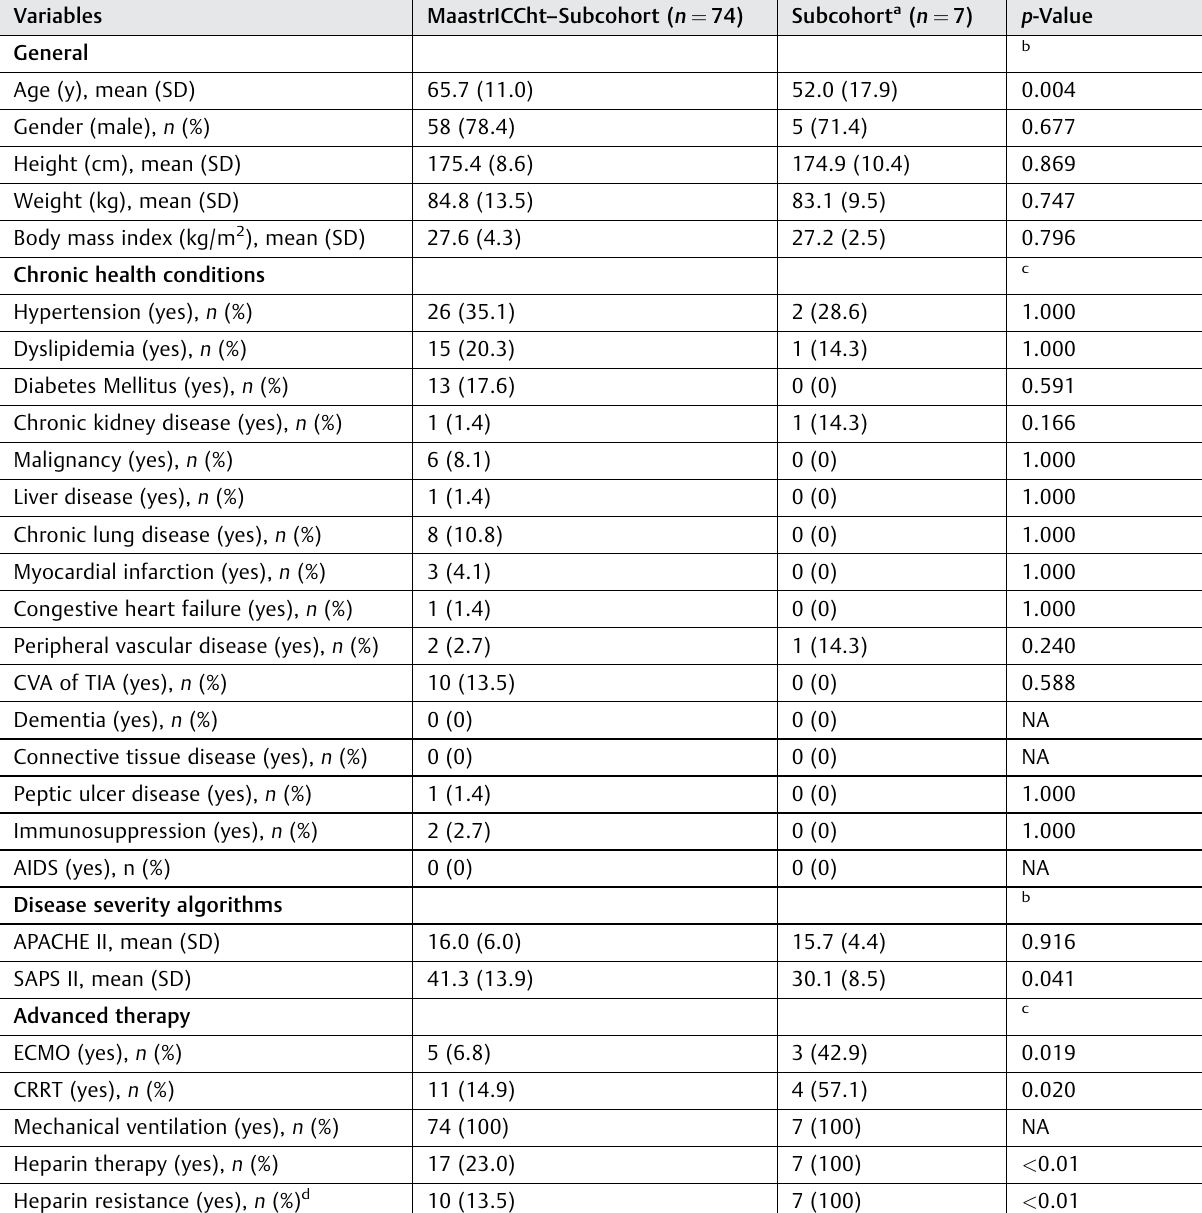
Table 1 Comparison of the patient characteristics between the Maastricht Intensive Care COVID cohort (MaastrICCht) and the seven individual cases of the present